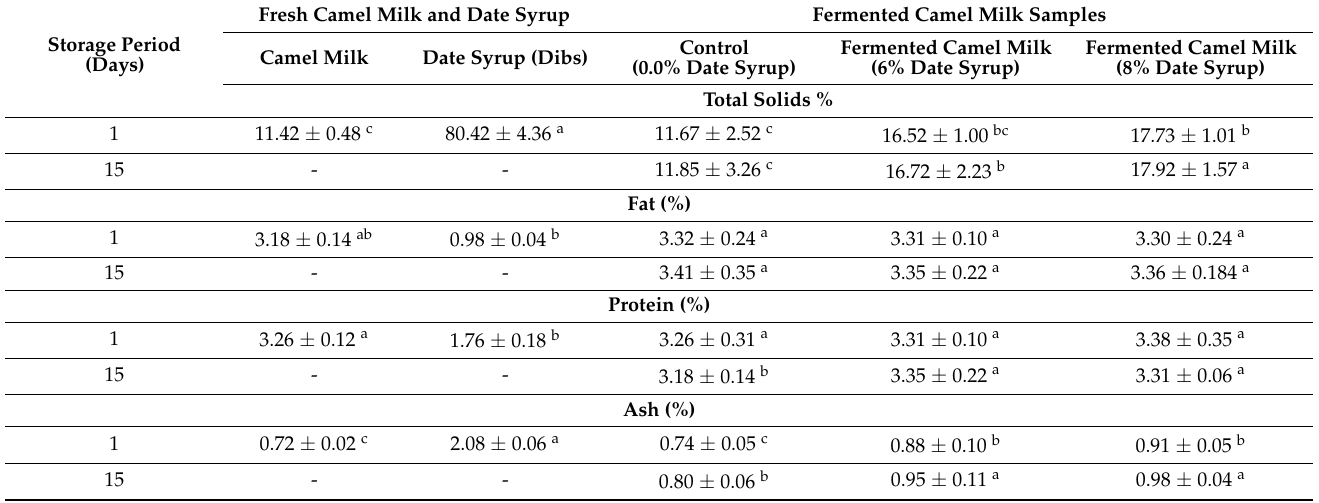
Table 2. Influence of the addition of date syrup on the chemical composition of fresh camel milk, date syrups, and fermented camel milk of both the control (yogurt from camel milk) and yogurt from camel milk with the date syrup during the cooled storage